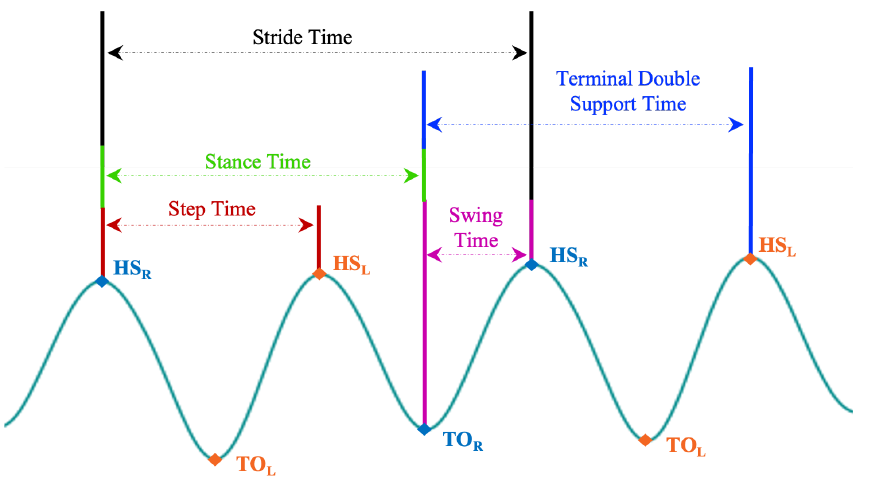
Figure 12. Illustration of how each temporal gait feature is defined on the AccAP signal. The Heel Strike of the right foot (HS R ) is used as a reference. (HS L ) is the HS of the left foot, and TO R and TO L are the toe-off of the right and left foot,